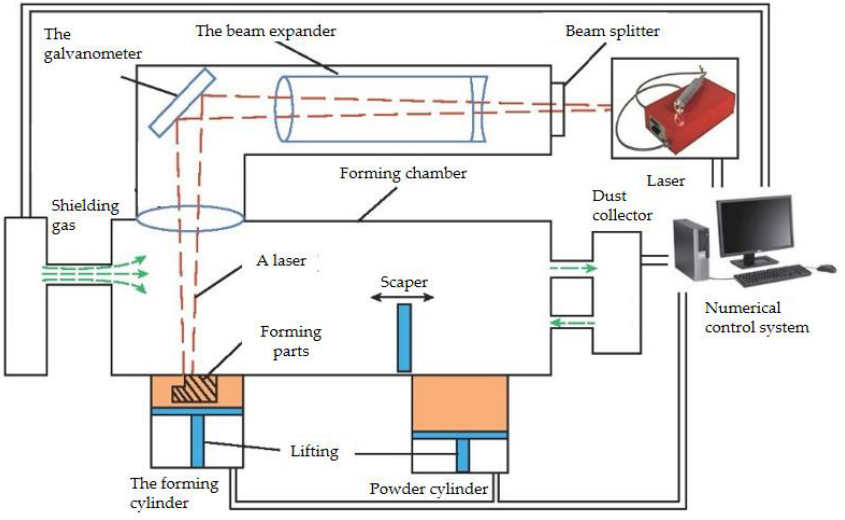
Figure 5. LPBF principle [27]